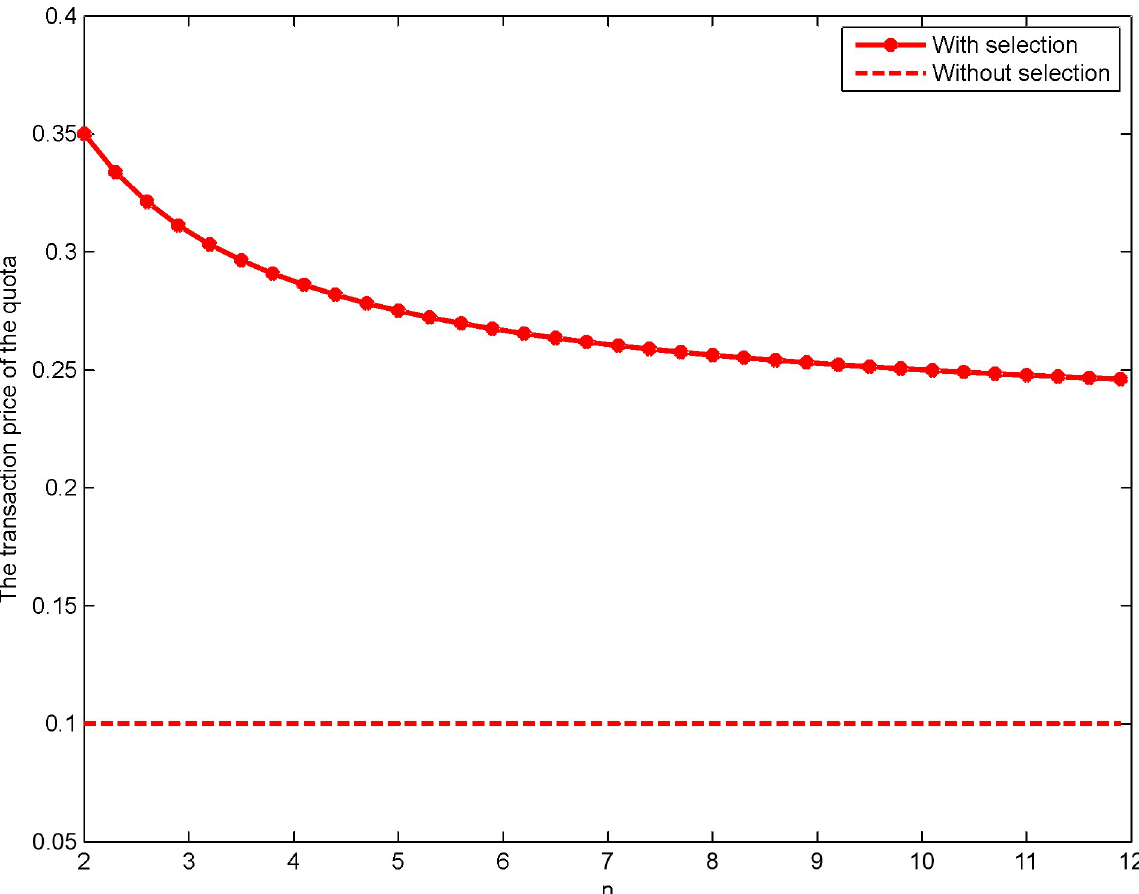
Fig 2. Impact of n on the transaction price of the quota for the second-price